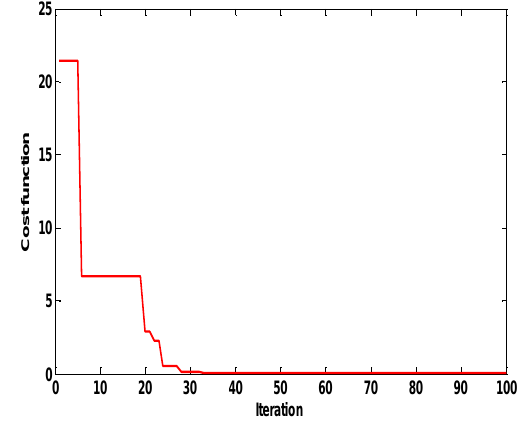
Figure 7. Desired Convergence of cost function.